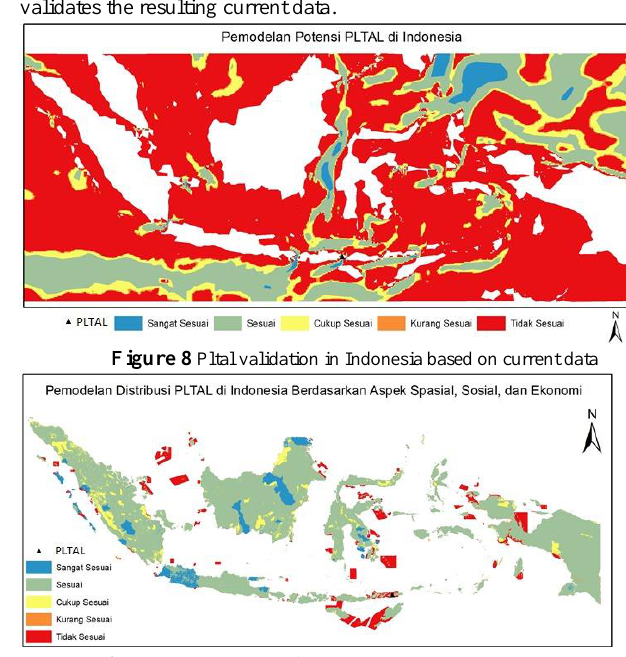
Figure 9 Validation of PLTAL position based on socio- economic and spatial